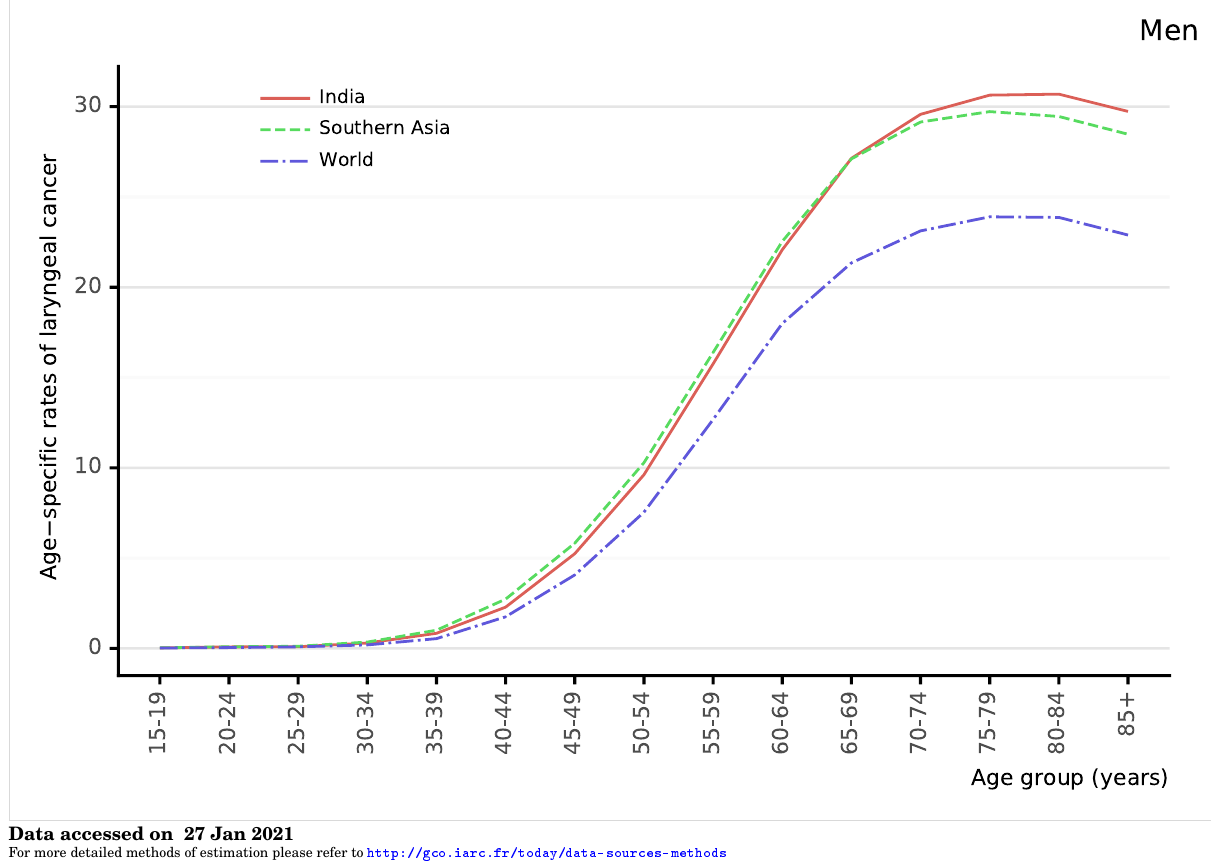
Figure 103: Comparison of age-specific laryngeal cancer incidence rates among men by age in India, within the region, and the rest of